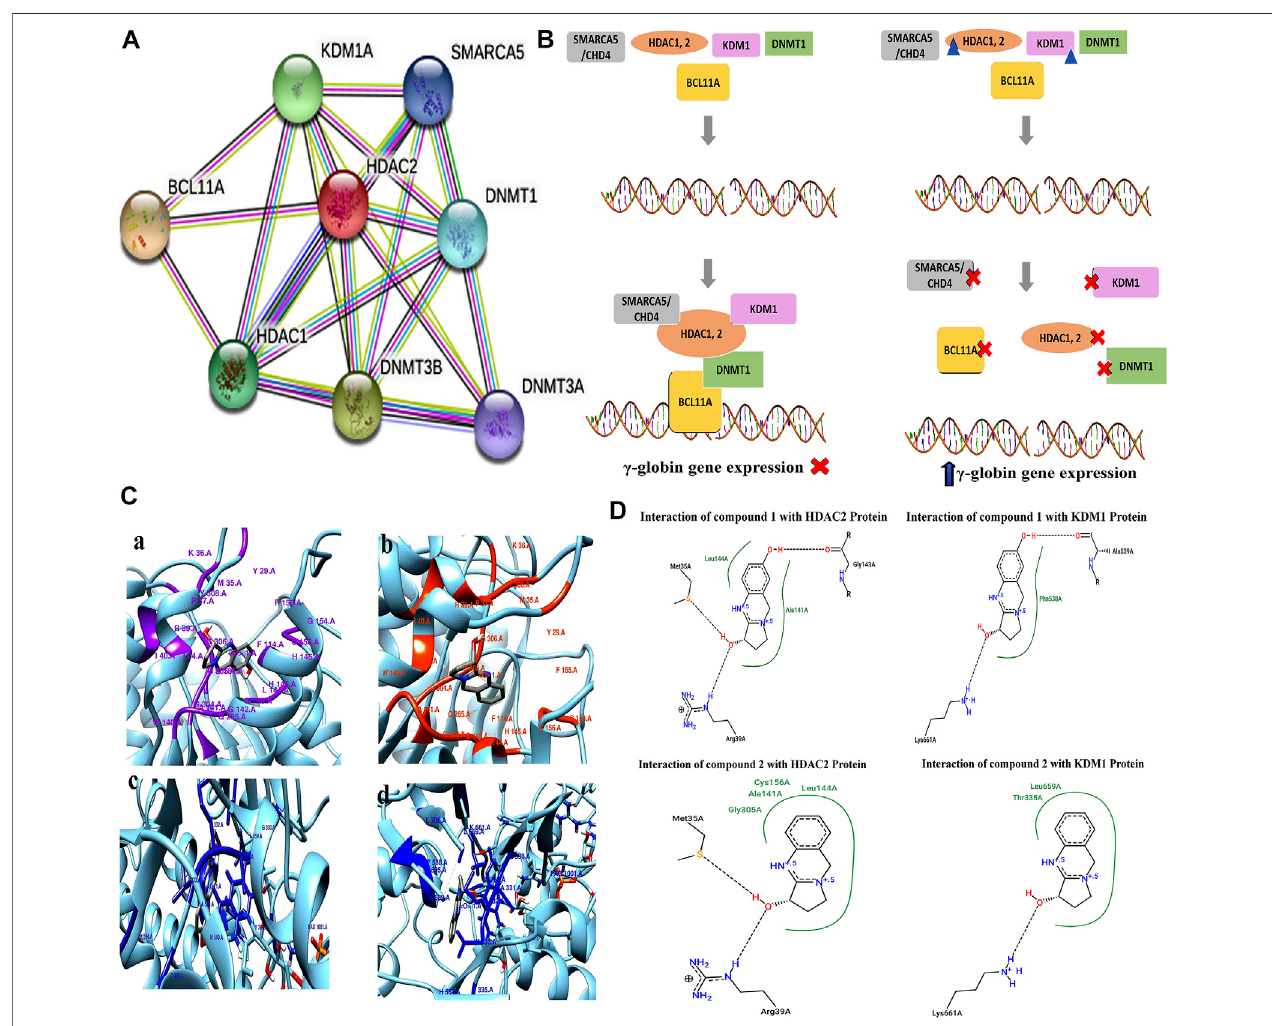
FIGURE8|(A) STRINGdatabase analysistogeneratePPIsofDNMT1,KDM1,HDAC1,HDAC2,andBCL11Aproteinsfor γ -globingenesuppressorcomplex. (B) Proposed epigenetic mechanism indicating the inhibitory action of pure compounds (triangular shape) of A. vasica on HDAC2 and KDM1 proteins in the reactivation of the γ -globin gene. (C) 3D interaction generated through Chimera shows the interaction of compounds 1 and 2 with HDAC2 and KDM1 protein. (D) 2D schematic view generatedthroughthePoseViewtoolforcompound 1 showinginteractionwithHDAC2protein throughG143,L144,M35A,andR39A,whilecompound 2 depicts interaction with M35, R39, G305, N141, L144, and C156 of HDAC2. In KDM1 protein, compound 1 interact through L661, A539, and P538. Compound 2 shows interaction with L661, T335, and L659.